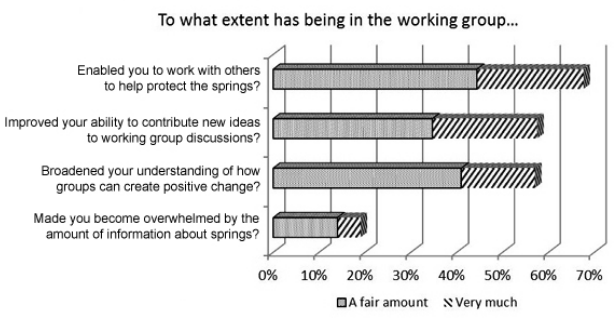
Fig. 2 . Respondent perceptions of impacts regarding